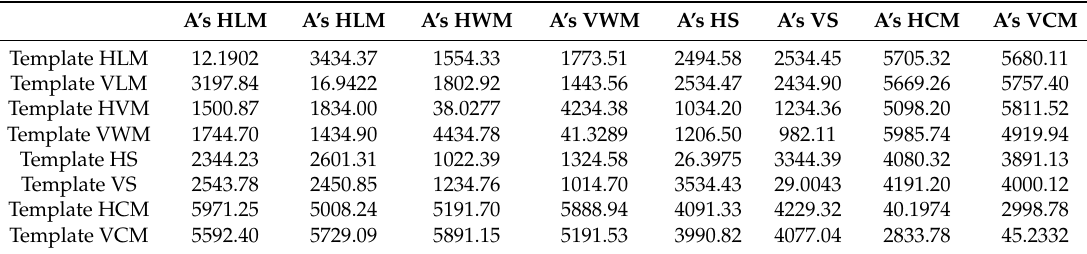
Table 2. Distance measurement of the two trajectory sequences.